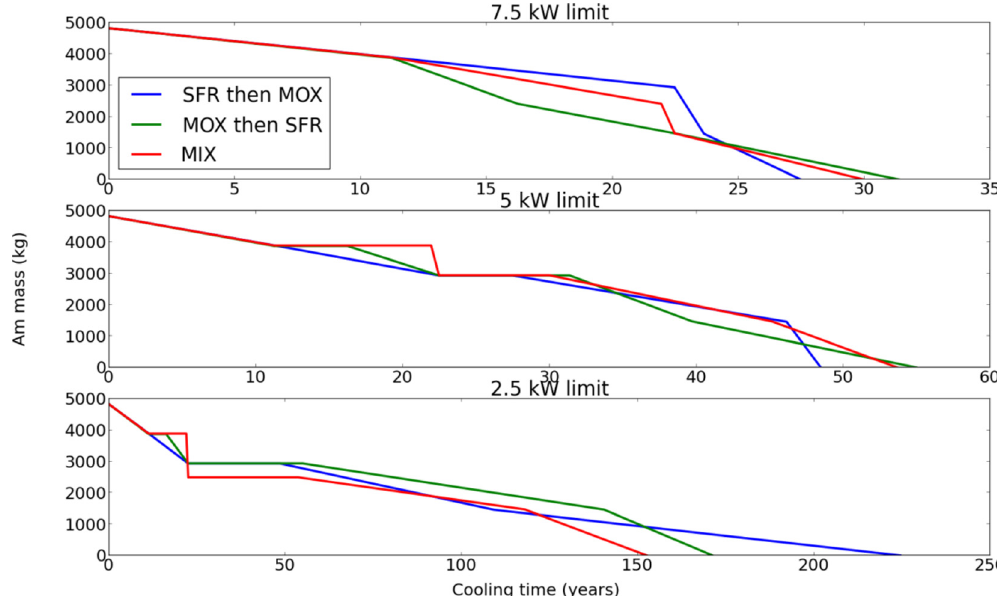
Fig. 3. Evolution of the americium in the fuel cycle depending on the strategy considered and on the reprocessing limit for coupled scenarios with MOX reactors and Table 5. Cooling time and americium content for the three strategies with sodium fast reactor studied here.